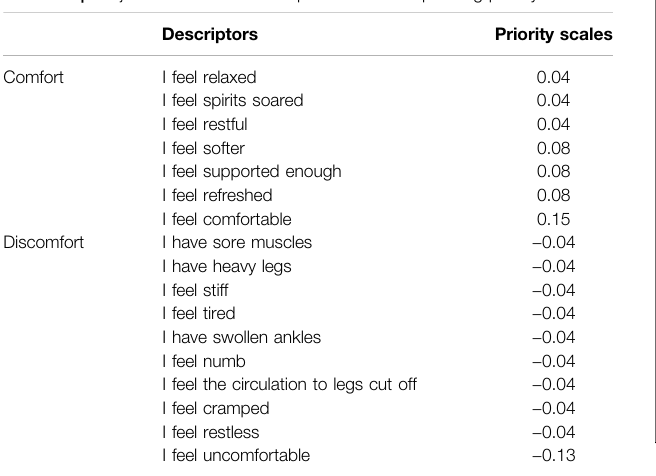
TABLE 2 | Subjective evaluation descriptors and corresponding priority scales.